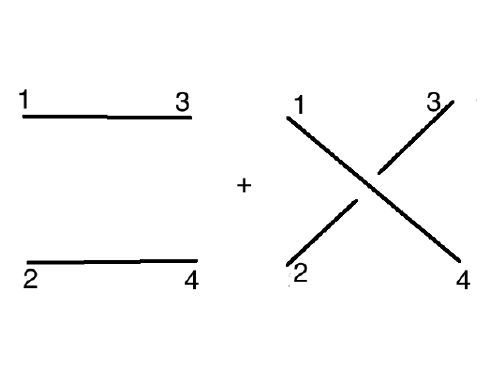
1234 comes from these \zero- h i